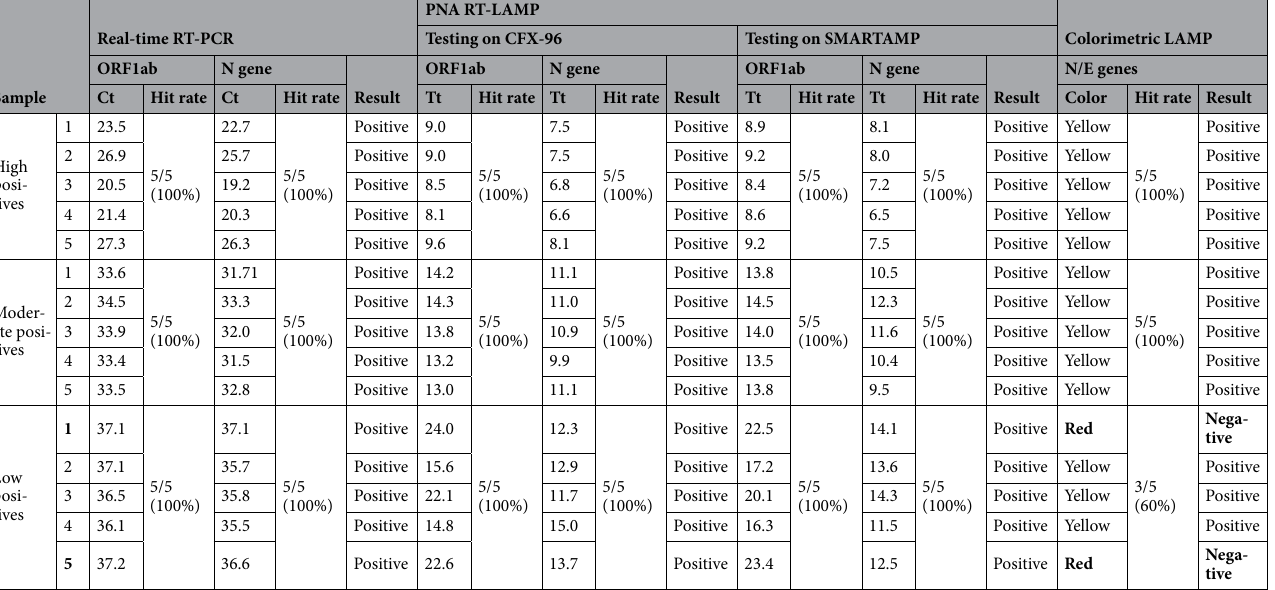
Table 5. Comparative table of clinical positive samples testing. 15 samples of high, moderate, and low positive groups exhibited positive amplification signals when tested using the PNA RT-LAMP assay on both CFX-96